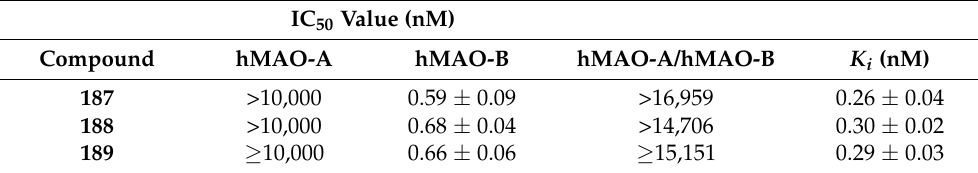
Figure 15. Chemical structures of monoamine oxidases (MAO) inhibitors. Table 2. Affinities of monoamine oxidases B (MAO-B)